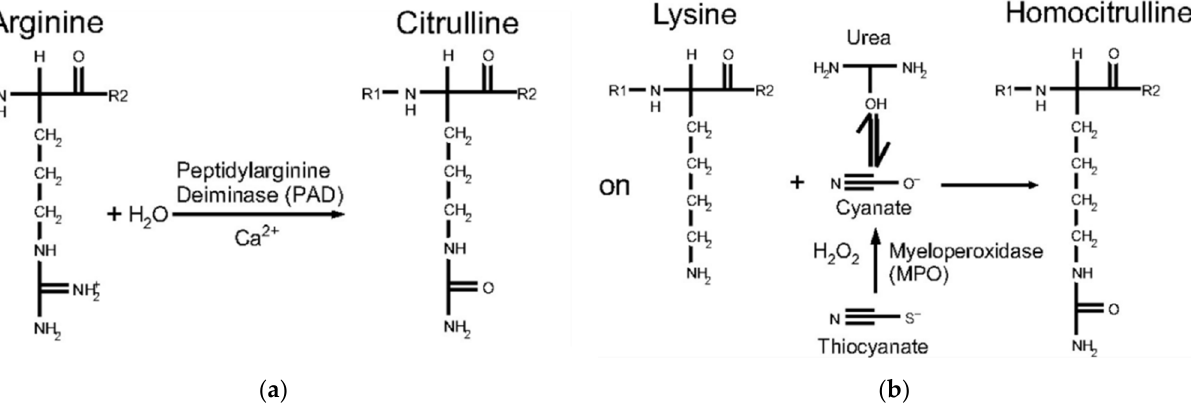
Figure 1. Citrullination ( a ) and carbamylation ( b ) occurring on different amino acids via different mechanisms but yielding similar end-products (Adapted from Shi et al., 2011 [2]).